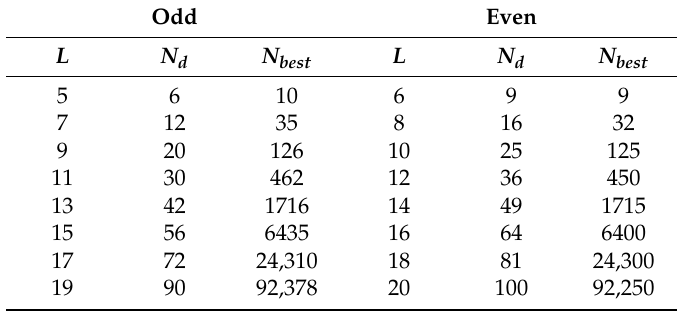
Table 1. Number of optimum codes and Maximum detection window number in different code length. Odd